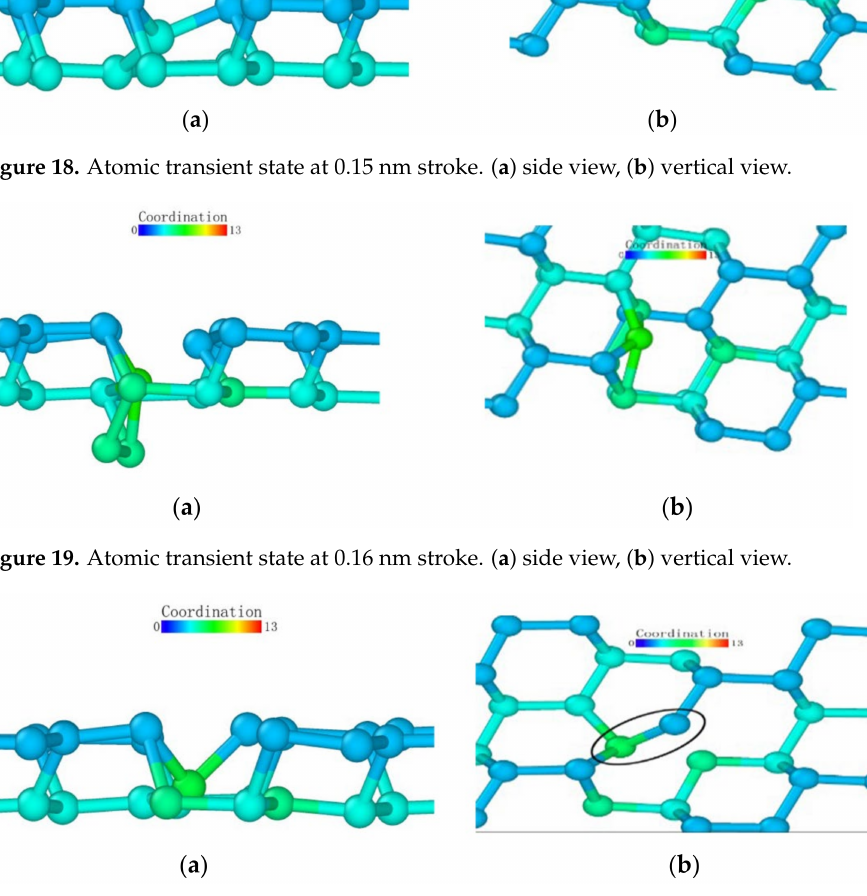
Figure 20. Atomic transient state at 0.23 nm stroke. ( a ) side view, ( b ) vertical view.